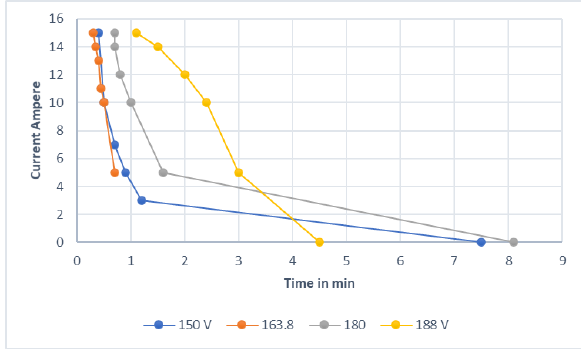
Figure 5: Current–time chronograms at different